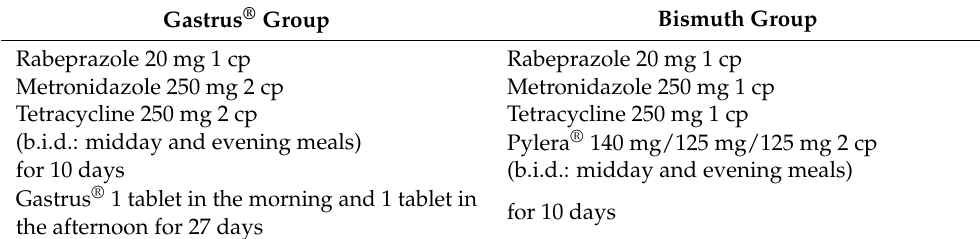
Figure 1. Study design of the controlled trial. The symbols * and § represent the treatment according to the Table 1. Table 1. Regimens used in the trial.